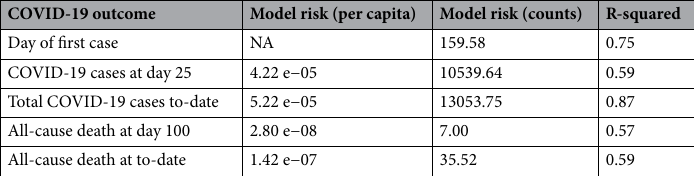
Table 2. Cross validated superlearner risk across COVID-19 Outcomes.